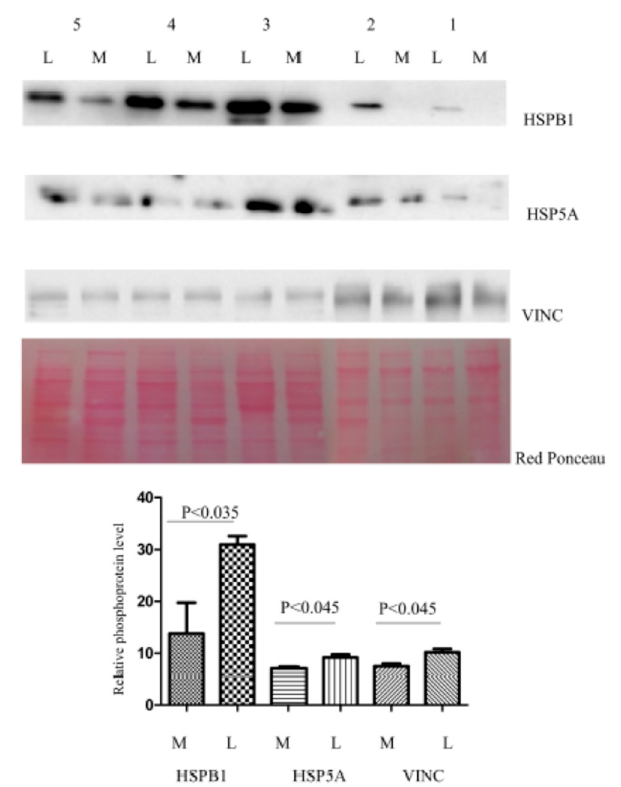
Figure 3. Western blot analysis was utilized to confirm the alteration of phosphorylation of proteins HSPB1, VINC and HSPA5 in paired myometrium (M) and leiomyoma (L). The intensity of immunostained bands was normalized against the total protein intensities measured from the same blot stained with Red Ponceau. Number 1-5 indicate the patients. The bar graph shows the relative expression (band density) of HSPB1, VINC and HSPA5 in the myometrium and the leiomyoma. Results are shown as a histogram (P < 0.05) and each bar represents mean ± standard deviation.